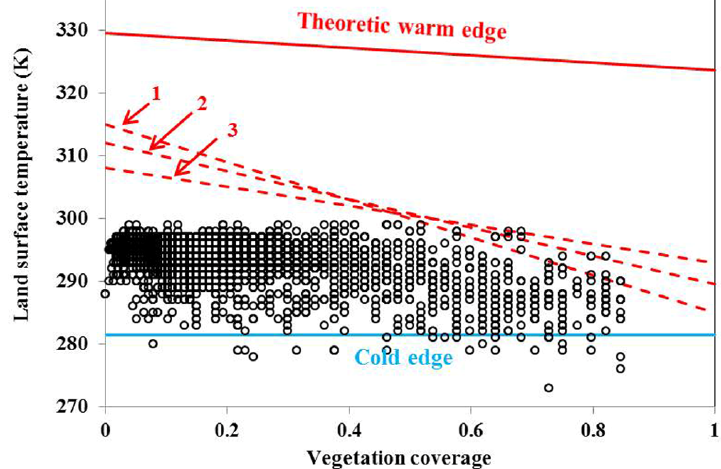
Figure 8. Scatter plot of the F c /LST space and its warm and cold edges over the